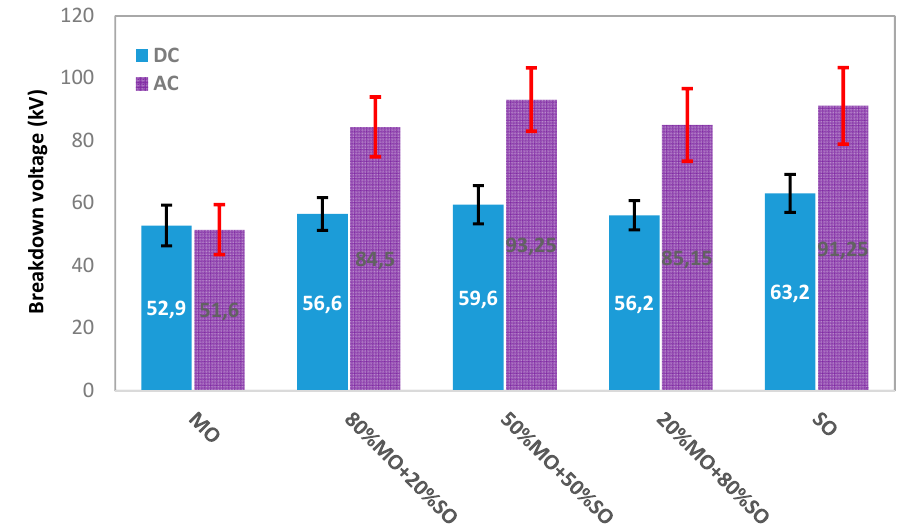
Figure 19. Average breakdown voltage of mineral oil and synthetic ester oil mixtures; the bars indicate the standard deviation.